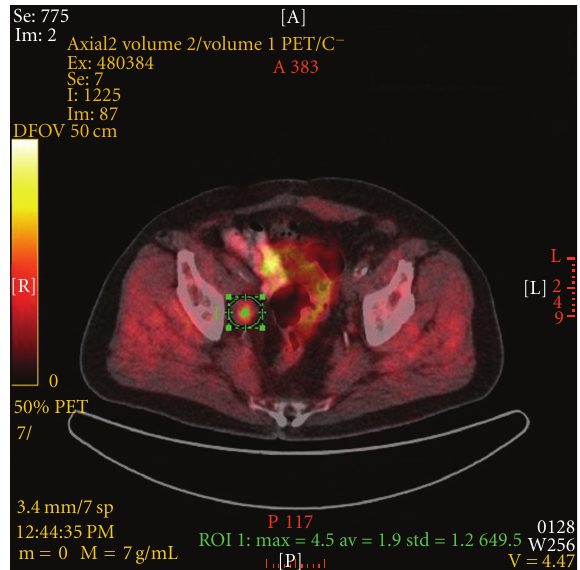
Figure 1: Integrated [ 11 C]choline PET/CT shows a single LNM in the right iliac region. The LNM was confirmed histopathologically after secondary resection. (Source: Clinic of Nuclear Medicine and Institute of Clinical Radiology, University Hospital Muenster,